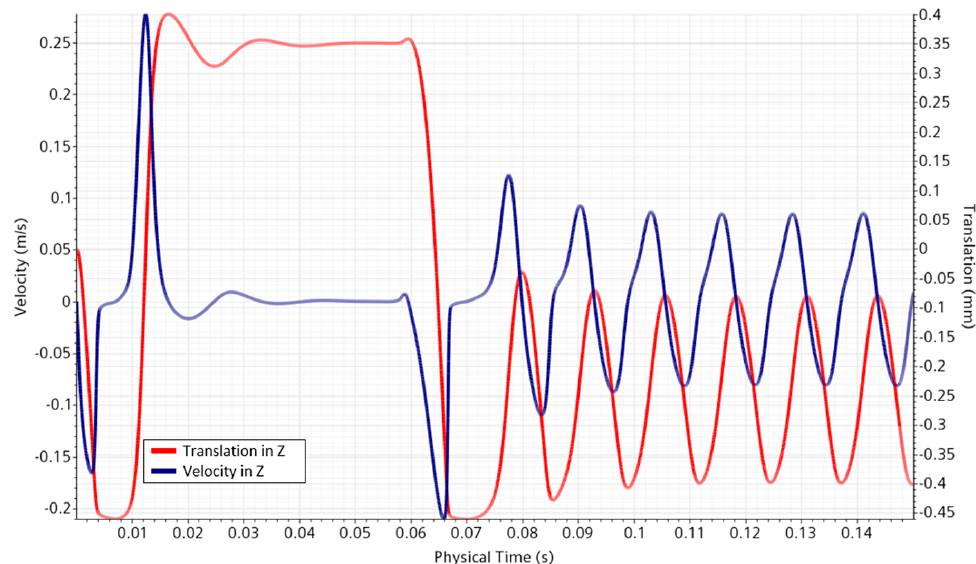
Figure 15. The plate’s velocity and translation profile in the valve with a differential pressure of 1.3 bar. The water began to enter at 0 s, then the oil entered at 0.04 s. The translation and velocity were calculated using the plate’s center mass. Therefore, negative translation values implied a descending behavior of the plate on the vertical axis. The vibration was quickly damped between 0.015 s and 0.04 s. The valve’s behavior in the open position showed a constant oscillation between 0.4 mm and 0.1 mm in the opposite direction of the flow. Oscillation was visible, as were changes in the presence of different fluids in the domain.